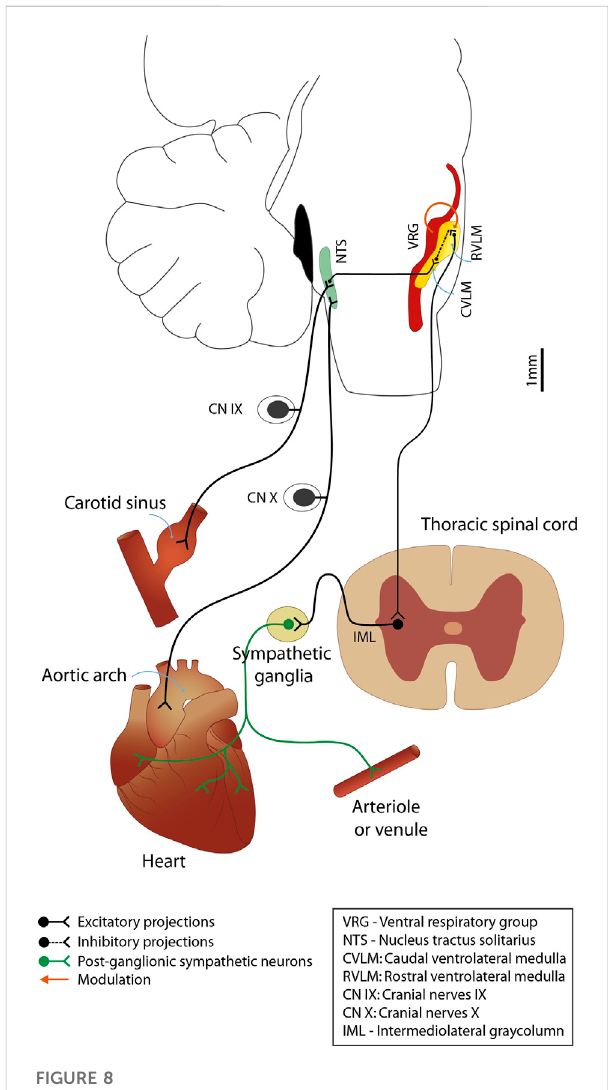
FIGURE 8 A schematic representation of the autonomic nervous system regulation of the cardiovascular system. Changes in blood pressure produce changes in the diameter of the carotid arteries and aorta, sensedbymechanoreceptorsinthecarotidsinusandaorticarch. This information travels through the afferent pathways: vagus nerve (CNX) and glossopharyngeal nerve (CNIX), to the main integrating centerofcardiovascularcontrol:thenucleusofthesolitarytract(NTS). The NTS regulates the activity of the rostral ventrolateral medulla (RVLM) through inhibitory neurons in the caudal ventrolateral medulla (CVLM). RVLM is the main regulatory center of sympathetic output, and its activity modulates vascular tone and cardiac activity through efferent pathways. Close to RVLM is the ventral respiratory group (VRG), a column of neurons that fi re action potentials in phase with respiration and which, due to its proximity to RVLM, could be responsible for the modulation of sympathetic output during